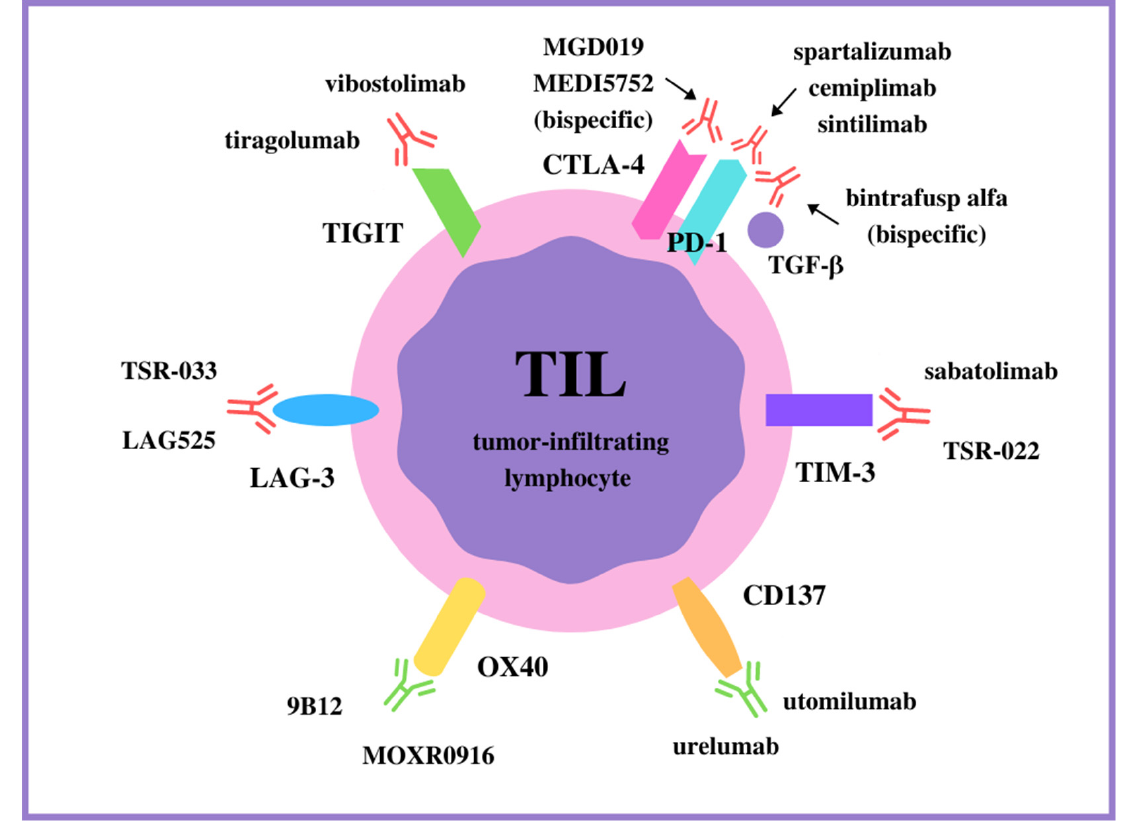
Figure 1. The monoclonal antibodies targeting positive (in green) and negative (in red) immune checkpoints on T cells.